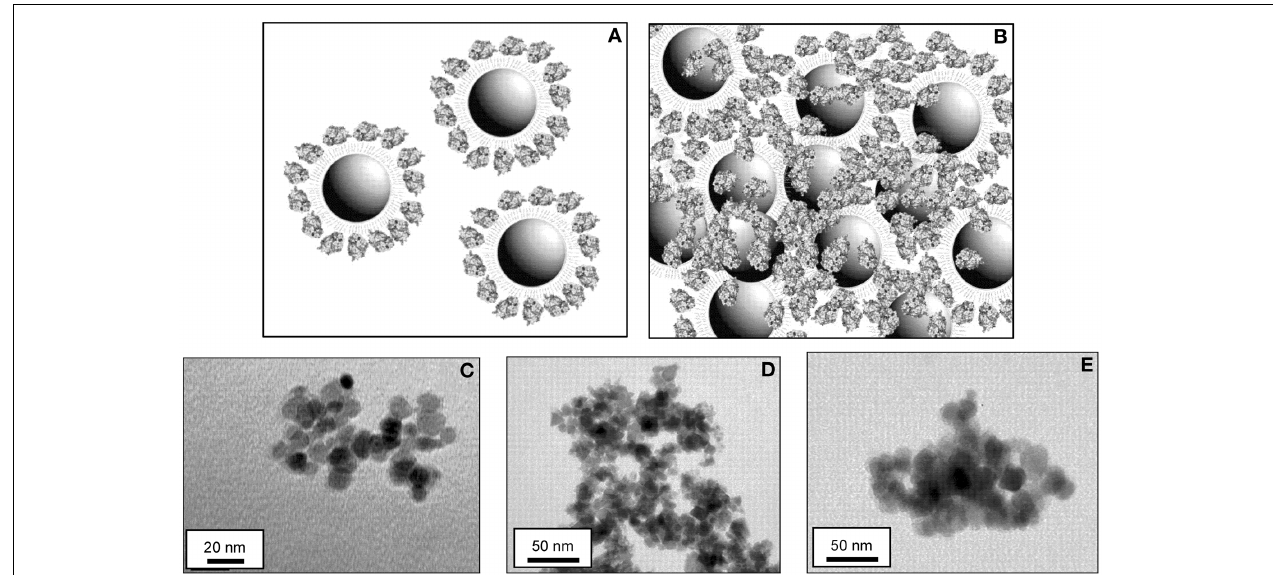
FIGURE 2 | Scheme of a scale representation of the magnetic biocatalysts obtained with CALB and TEM micrographs of the magnetic biocatalysts of CALB used in this work. Artwork is a hypothetical model of (A) MNP-CALB and (B) mCLEA-CALB complexes. Both models simulate a cross-section of a three-dimensional structure. The